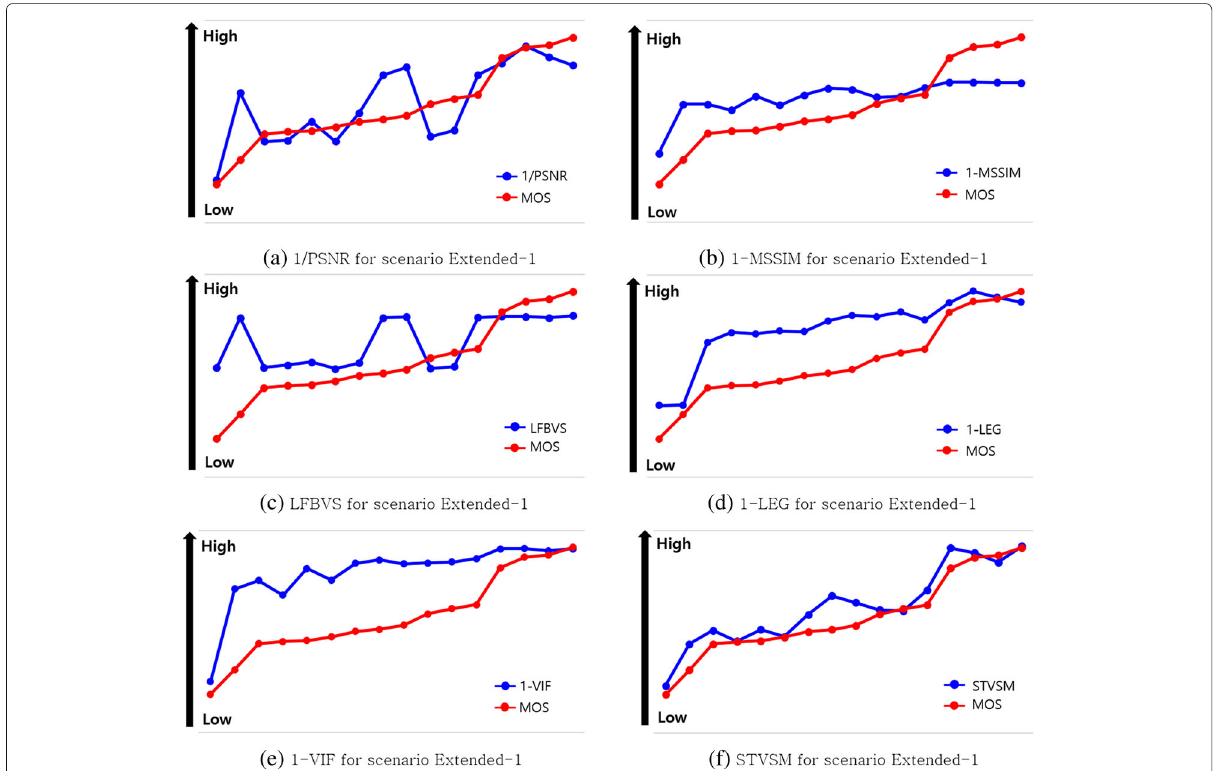
Fig. 4 Visual security evaluation results of objective (blue) and subjective (red) methods for scenario Extended-1 (from the subfigure ( a ) to ( f ) in case of Foreman video, x -axis represents different encryptions which result in different MOS in the increasing order and y -axis represents visual security). This shows the evaluation results from the objective metrics (PSNR, MSSIM, LFBVS, LEG, VIF, and STVSM) and the subjective scores of 66 subjects for various encrypted videos additionally considering a special option of the implemented encryption method. By considering the special option, we have 16 encrypted videos which enables us to study the visual security evaluation more detailed as compared to Fig. 3. From the subfigure ( a ) to ( f ) in case of Foreman video, x -axis represents different encryptions which result in different MOS in the increasing order and y -axis represents visual security. Similar to Fig. 3, Fig. 4 aims to present how each objective metric correlates with the subjective scores from the human eye’s